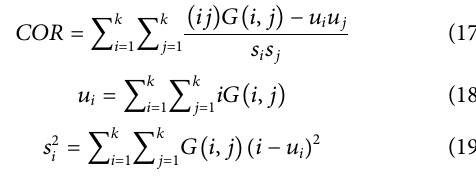
Frontiers in Physics |